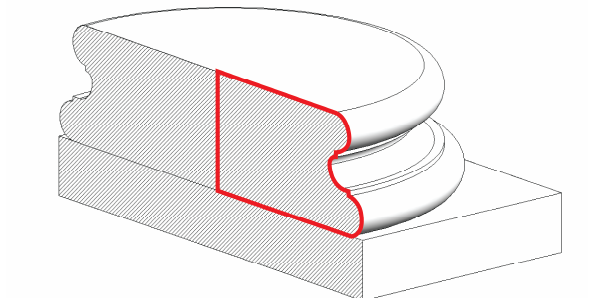
Figure 7. Dense point cloud of a . capital from the Temple of